Question: Briefly state, in one sentence, what is plotted here.
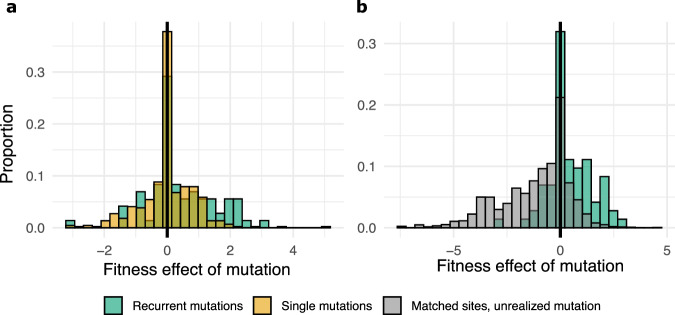
Answer: Distribution of fitness effects for recurrent and non-recurrent, single mutations. a Comparison of recurrent mutations ( N = 72) versus single-appearing mutations ( N = 446) in persistently infected individuals. b Comparison of recurrent mutations with other amino acids found at the same sites. Fitness values represent the potential for these mutations to spread between hosts, as determined from a globally representative phylogeny 34 . Source data underlying this figure can be generated using the custom code available at the repository described in the Code Availability statement.